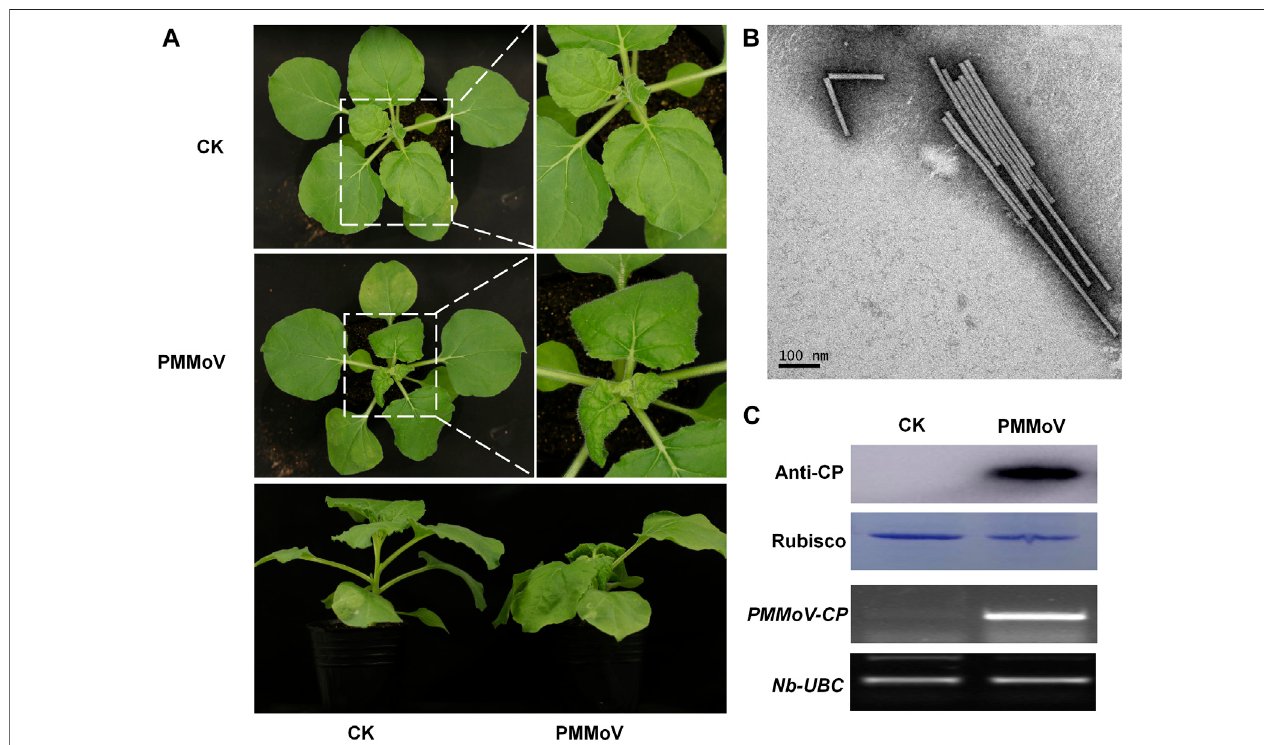
FIGURE 1 | Symptoms caused by PMMoV in N. benthamiana infected with a full-length cDNA infectious clone. (A) Phenotype of N. benthamiana plants agroin fi ltrated with viral infectious clone combinations or empty agrobacterium (CK) at 28 days post in fi ltration. (B) Virions puri fi ed from leaves infected by the PMMoV infectious clones and observed by TEM. Bars represent 100 nm. (C) Detection of PMMoV CP by Western blot (upper panels) and RT-PCR con fi rming the presence of viral RNAs (lower panels) in systemic leaves of inoculated plants. Rubisco and Nb-UBC are the respective loading controls.